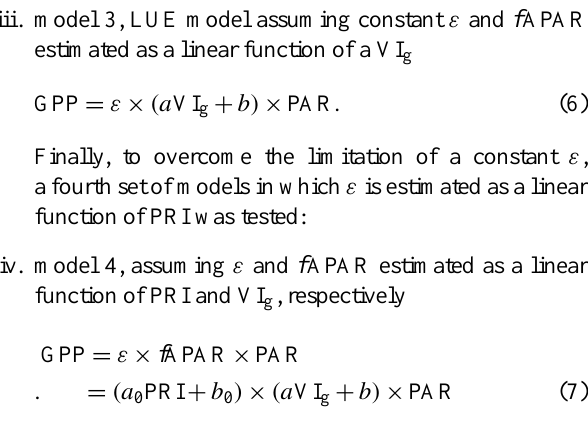
Fig. 1. Temporal changes of monthly grassland reflectance spectra collected at midday during 2009. Grey shaded areas represent the position and bandwidth of the MODIS spectral bands: B1 centered at 645 nm, B2 at 858.5 nm, B3 at 469 nm, B4 at 555 nm, B11 at 531 nm, B12 at 551 nm and B13 at 667 nm. White areas represent those of the MERIS sensor: b8 centered at 681.25 nm, b9 at 708.75 nm and b10 at 753.75